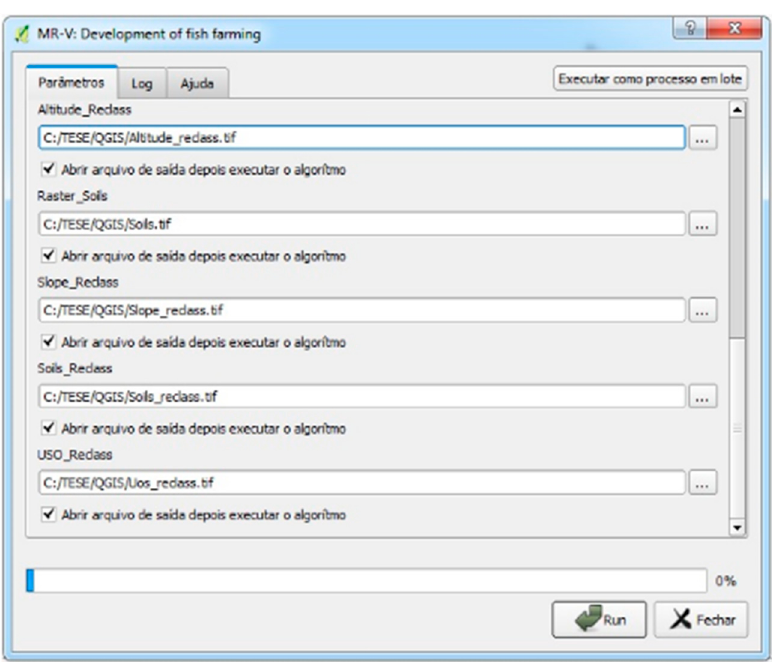
Figure 4. Defining the model to replace the original pixel values in accordance with the reclassification rules for the construction of thematic maps and suitability scale maps.